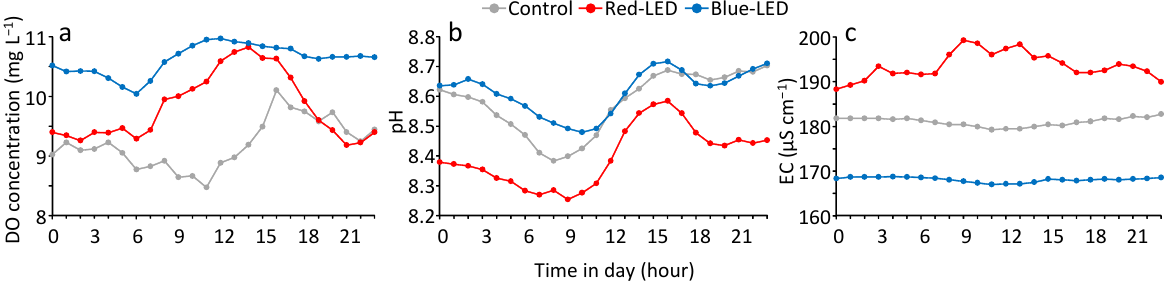
Figure 7. Diel change in DO ( a ), pH ( b ), and EC ( c ) based on the mean value of each hour in the day during period-3.